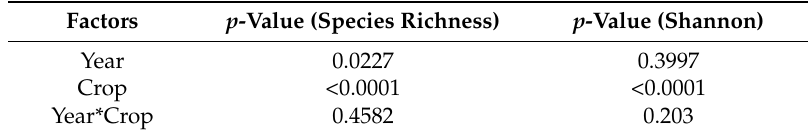
Table 1. Results of the Analysis of Variance (ANOVA) analysis of species richness and Shannon index.